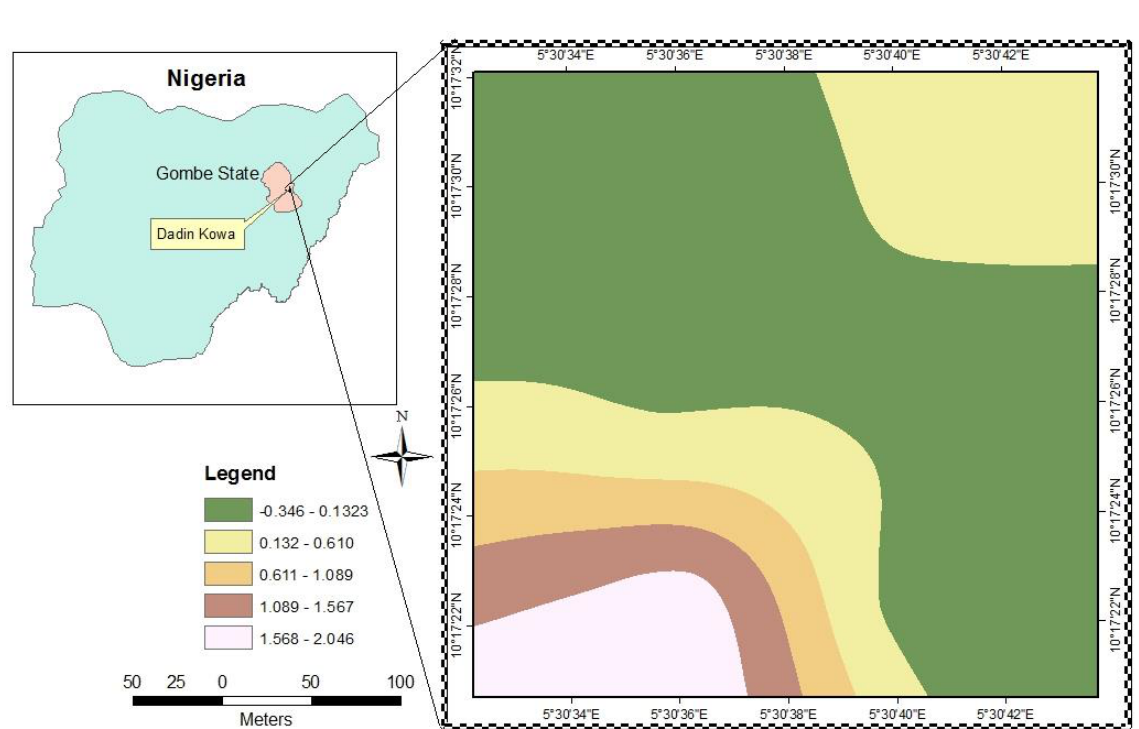
Fig. 5. Aquifer longitudinal conductance across the